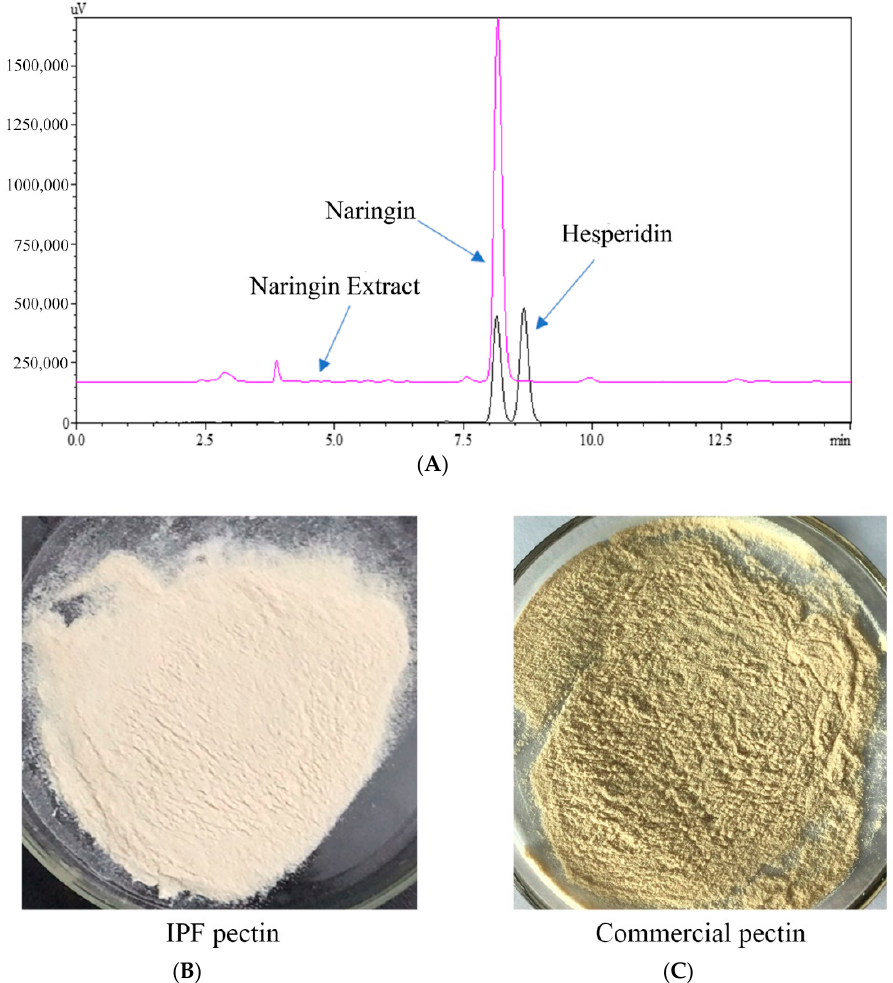
Figure 4. HPLC chromatogram of naringin extract ( A ); Freeze-dried IPF pectin ( B ) and purchased pectin ( C ).